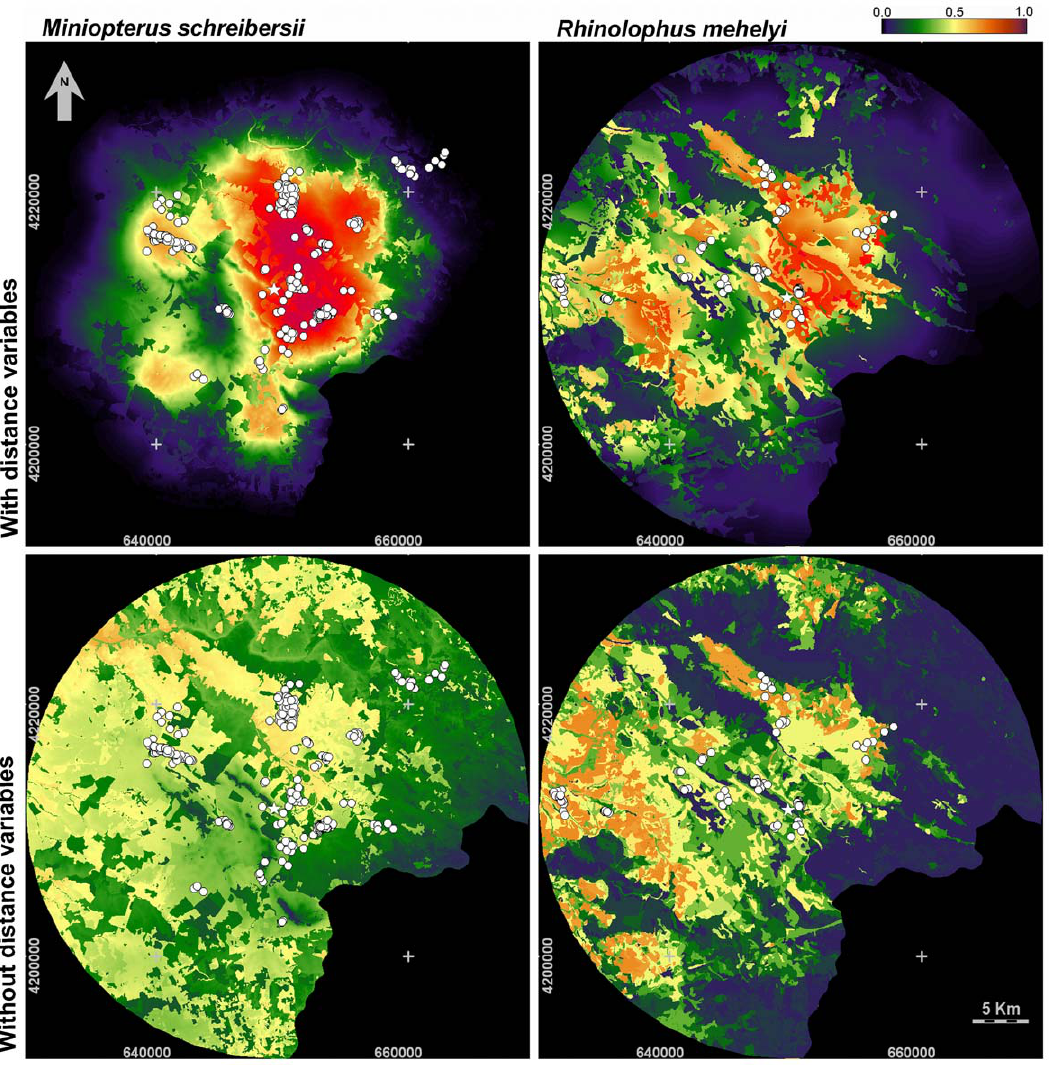
Figure 4. Maps of the predicted foraging suitability of the study area for Miniopterusschreibersii (left) and Rhinolophusmehelyi (right). These maps were drawn according to the best candidate models including (top) and excluding (bottom) distance variables (see models in Table 2). Habitat suitability is shown on a colour scale ranging from 0 (low suitability) to 1 (high suitability).